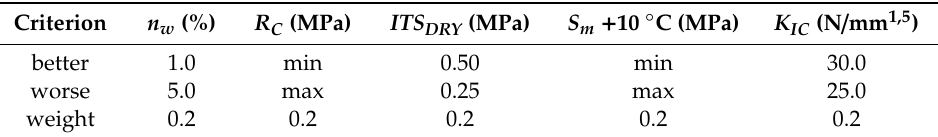
Table 17 lists the optimization criteria. Table 17. Optimization